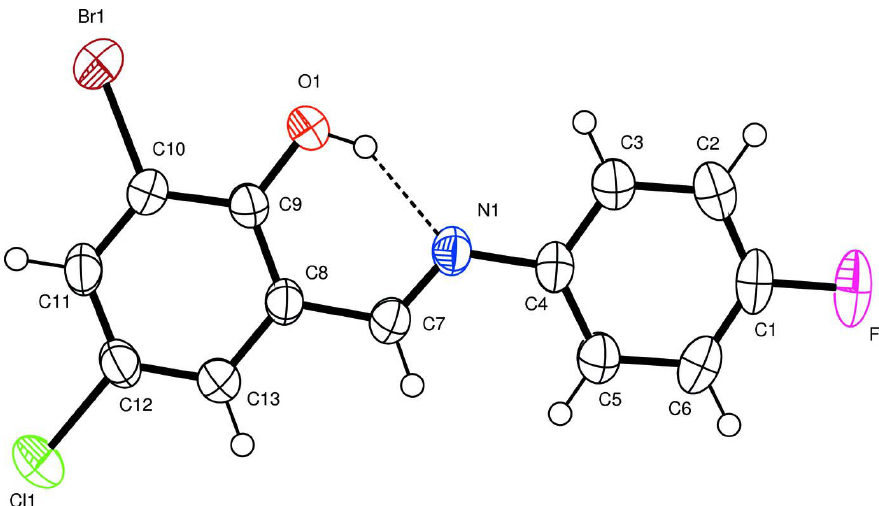
Figure 1 The ORTEP representation of the molecule with thermal ellipsoids at the 50% probability level.